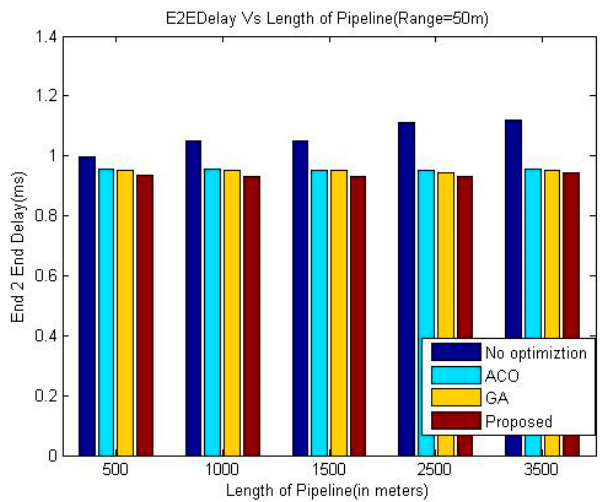
Figure 3. Comparison of End-to-End delay (Range 25 m).